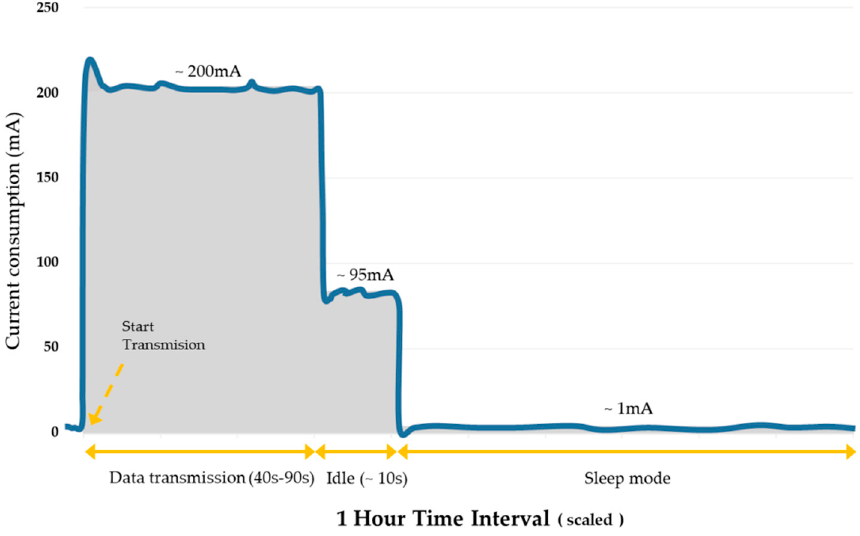
Figure 5. Power supply current profile for a 1-hour data cycle of remote node.